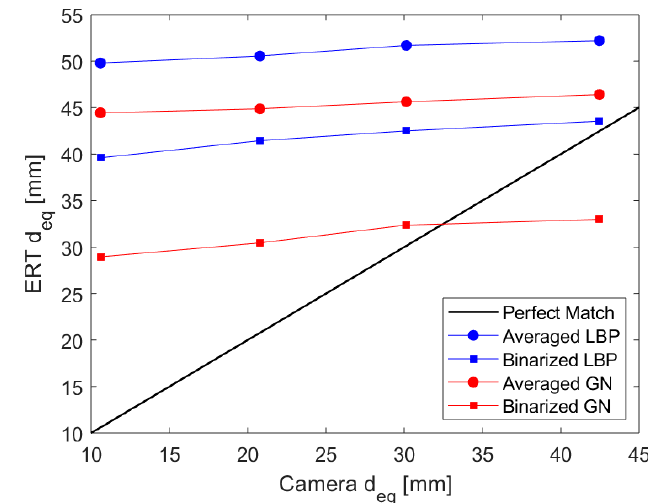
Figure 15. ERT reconstructed diameters plotted against the phantoms’ diameters obtained from the fast camera. The Linear Back Projection algorithm is represented in blue, with the average method presenting circle marks and the binary method presenting square marks. The results for the Gauss-Newton Reconstructed images are presented analogously but in red. The black line in the image provides a reference for a sensor mimicking the camera (parity of values).